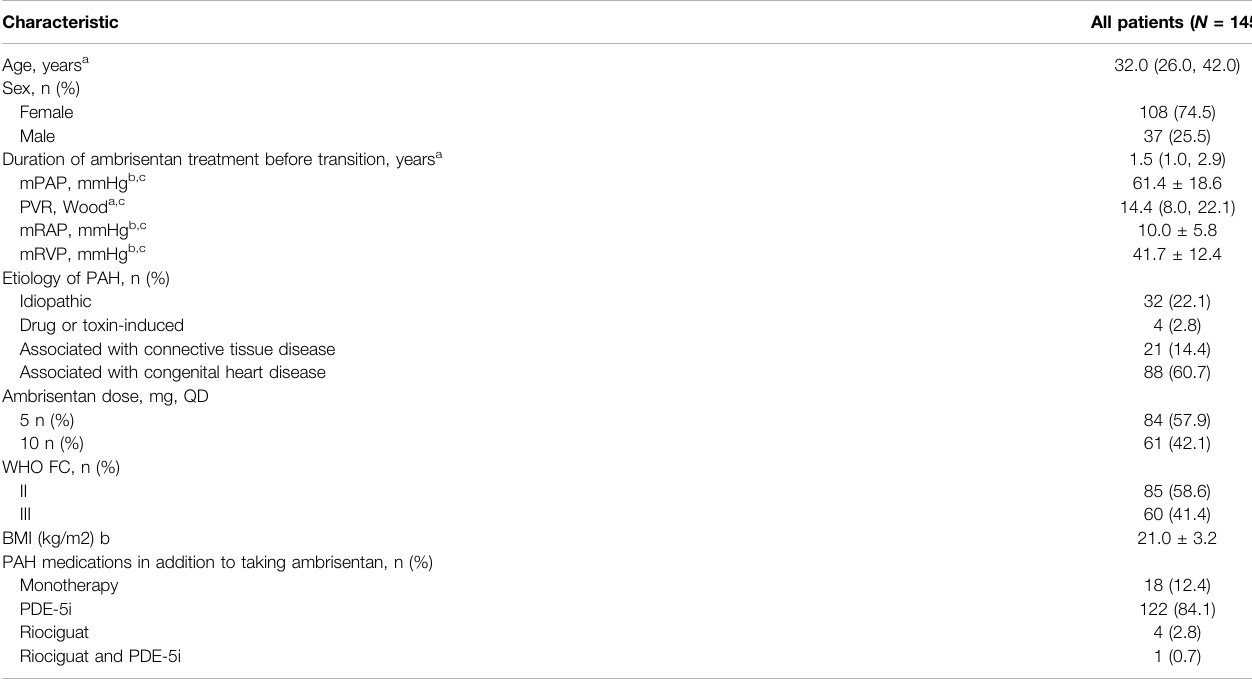
TABLE 1 | Baseline